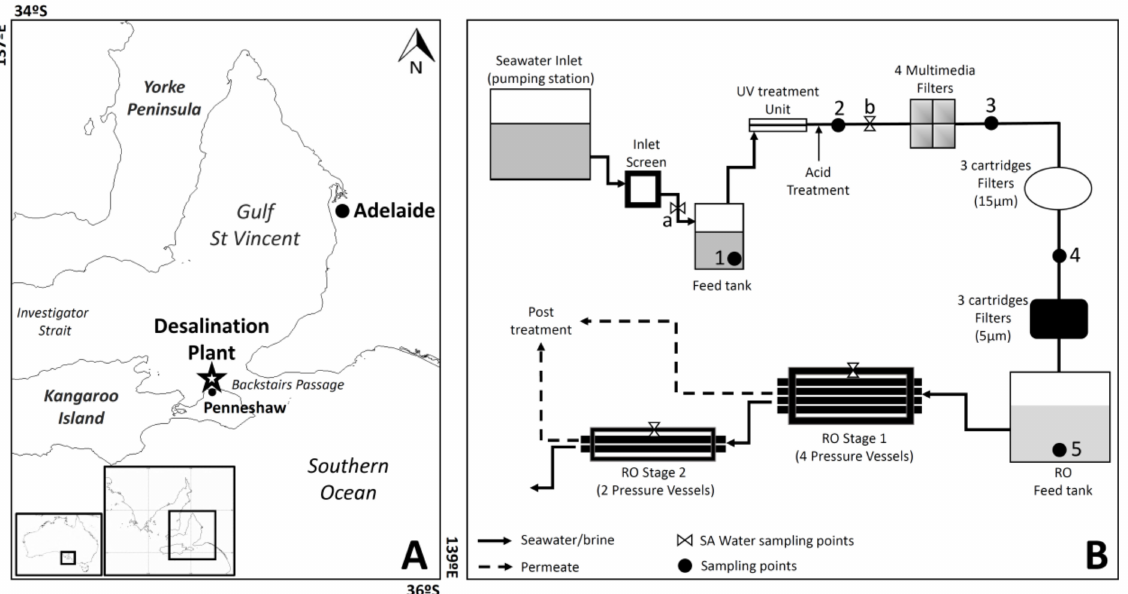
Figure 1. ( A ) Location of the Penneshaw SWRO desalination plant, and ( B ) schematic diagram of the Penneshaw SWRO desalination plant. Numbers indicate the different sampling points: (1) intake seawater, (2) post-MP-UV and acid treatment, (3) post-sand filter treatment, (4) post- cartridge filter treatment, and (5) SWRO feed tank water. The letters indicate the SA Water sampling points: (a) intake seawater and (b) intake seawater after acid